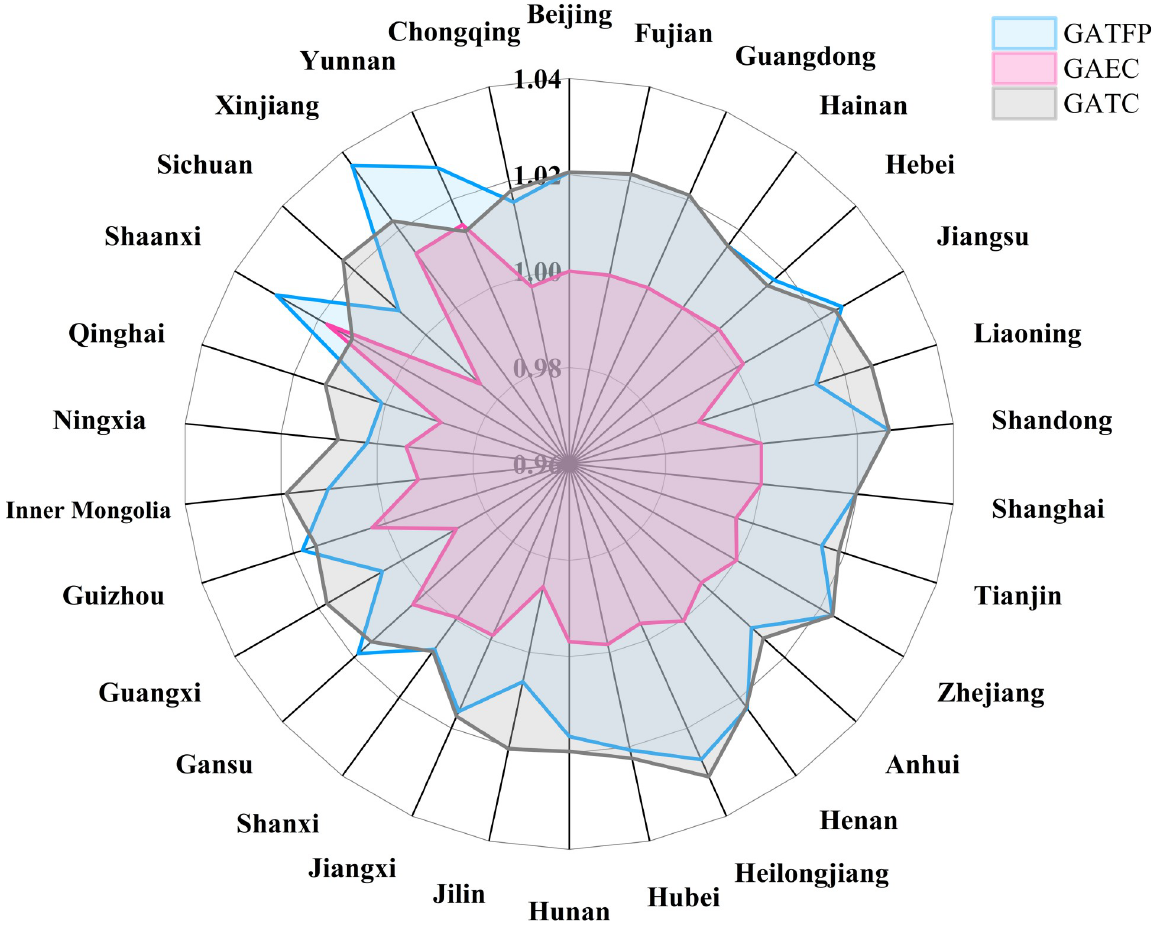
Fig 12. GATFP of national provinces and its decomposition.